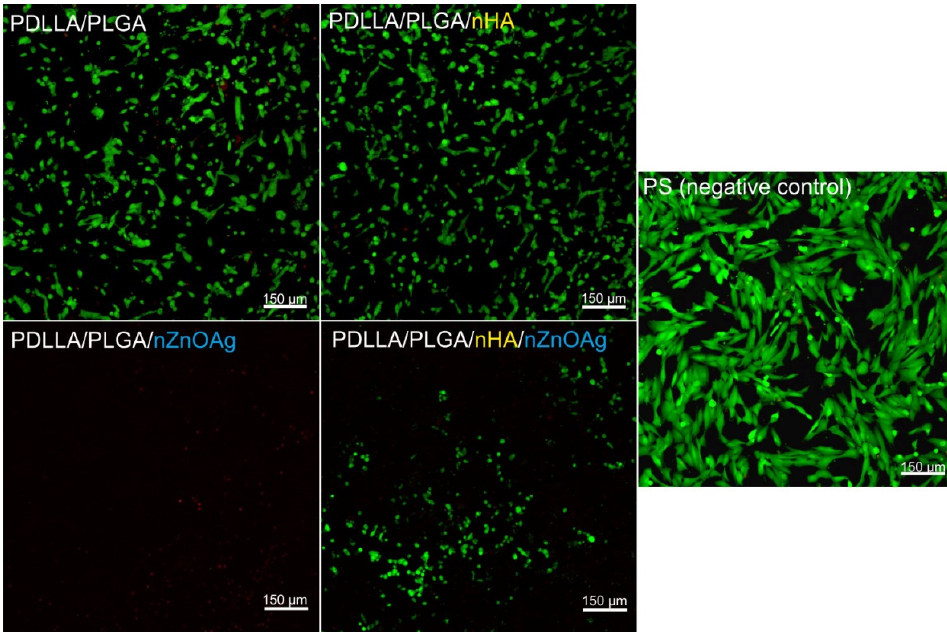
Figure 9. Confocal microscope images presenting the viability of normal human fetal osteoblasts (hFOB 1.19 cell line, ATCC CRL-11372TM) cultured on polystyrene (PS, negative control for cyto- toxicity) and on the investigated biomaterials after 24 h of incubation. Viable cells emitted green fluorescence and dead cells red fluorescence. Magnification: 100×; scale bar: 150 μ m.